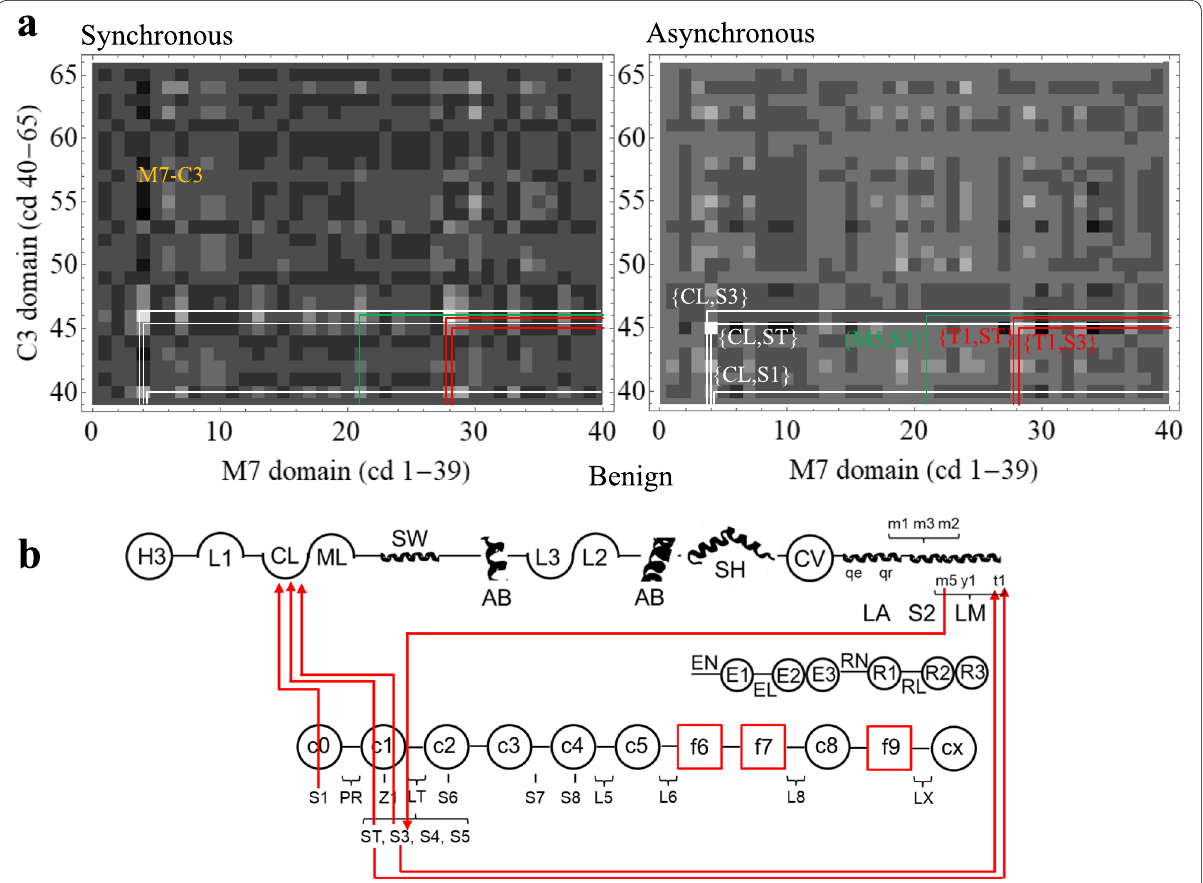
Fig. 6. βmys/MYBPC3 complex cross-correlation maps and their implied inter-protein domain linkages for benign outcomes. a M7-C3 region for synchronous and asynchronous maps and the portion of the correlation squares falling within them for benign outcomes taken from Supplementary Figure S4. b Red lines show most significant directed co-domain interactions between βmys and MYBPC3 for benign outcomes. Nomenclature otherwise identical to Figs. 4 and